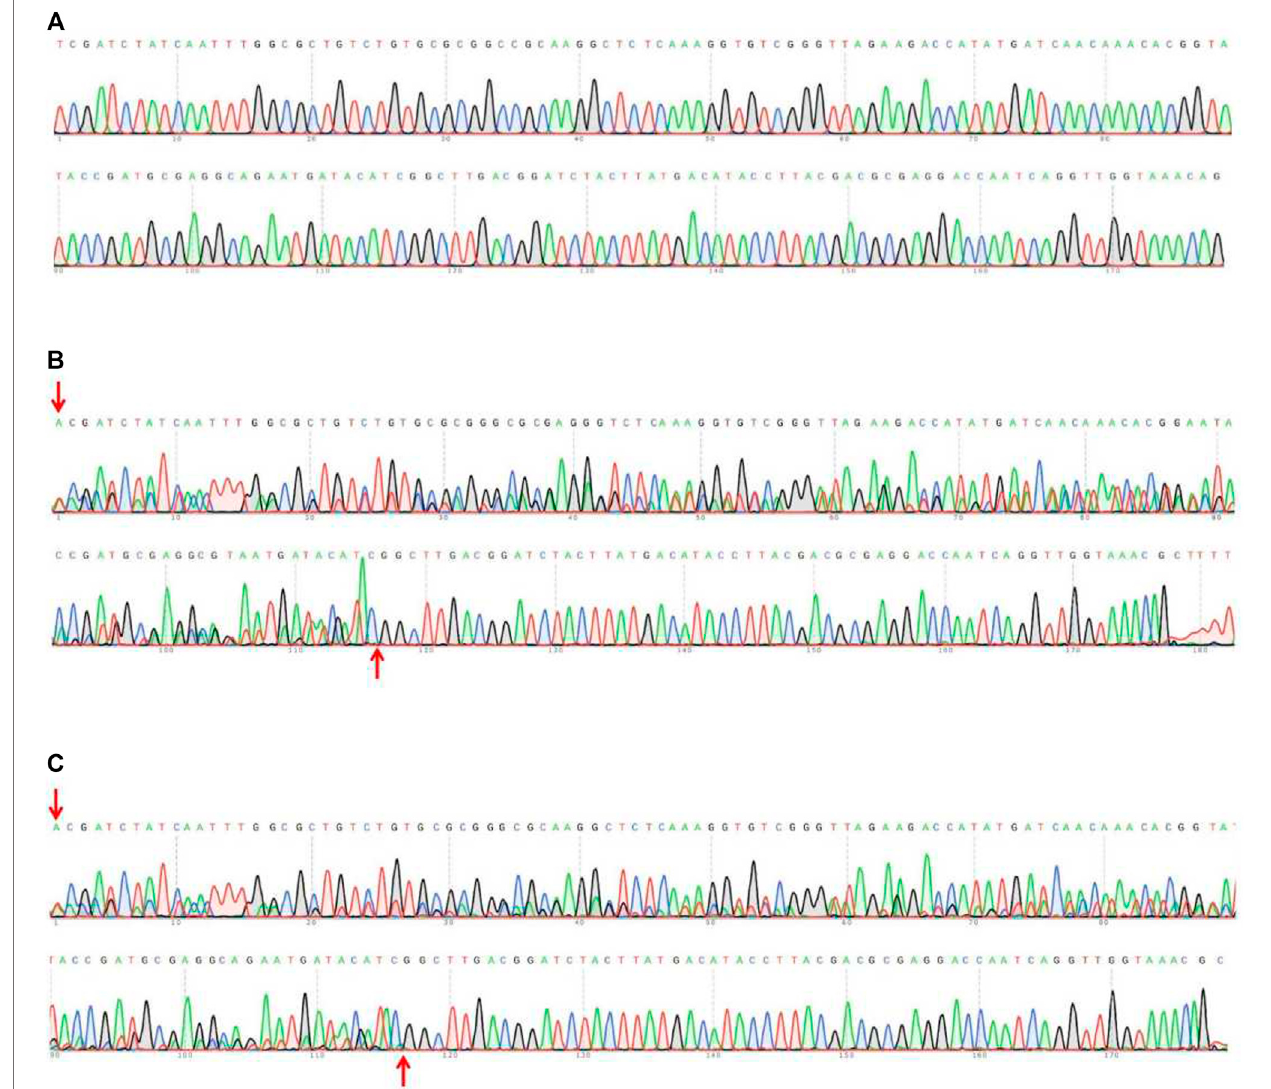
FIGURE 3 | Sequencing assay on the PCR products in wild-type (A) and injected F0 (B,C) . The sequences of F0 mutations showed multiple peaks, indicating the occurrence of the mutations. The fragments between the red arrows represent the mutated sites.